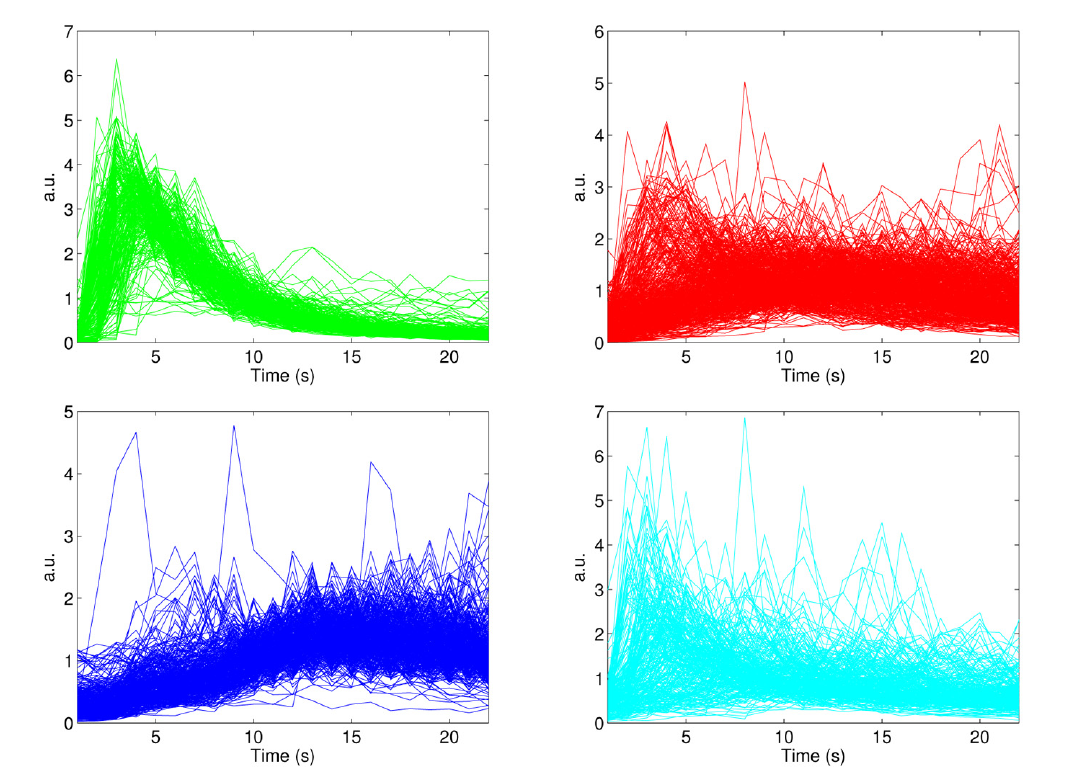
Figure 3. Envelopes in the time domain for all the signals of each of the four classes of events: green for earthquakes, red for landslides, blue for artificial explosions and cyan for events of the class